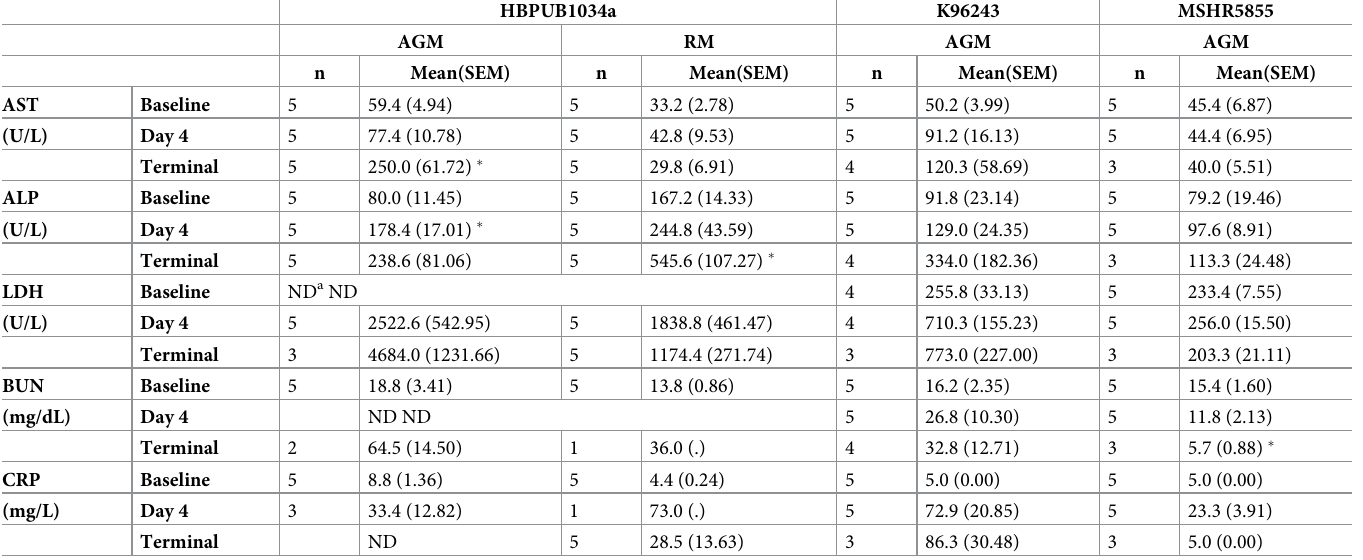
Table 1. Chemistry and other clinical manifestation of inhalation melioidosis.